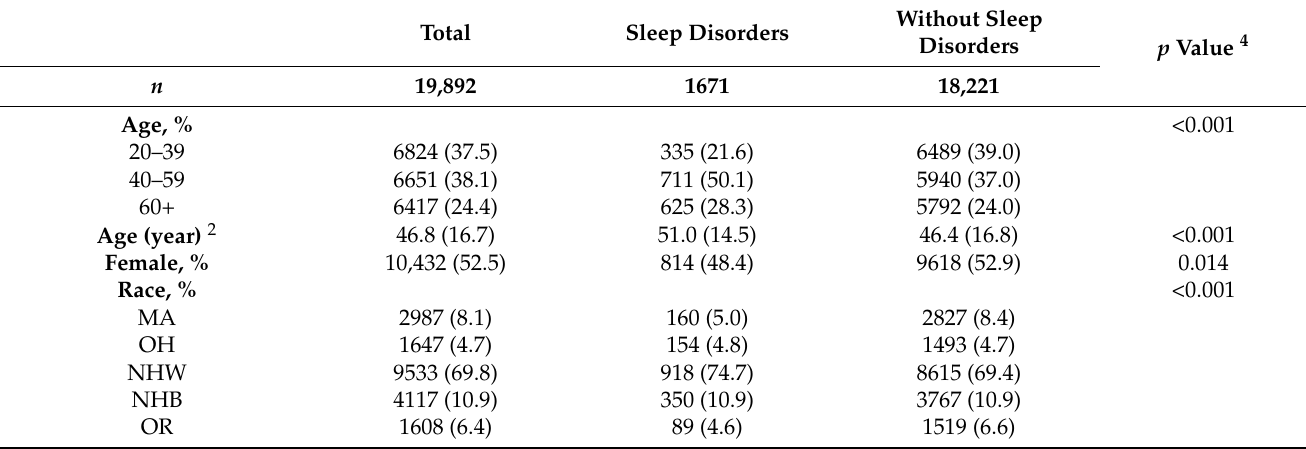
Table 1. Characteristics of study participants with and without sleep disorders, NHANES 2005–2014 1